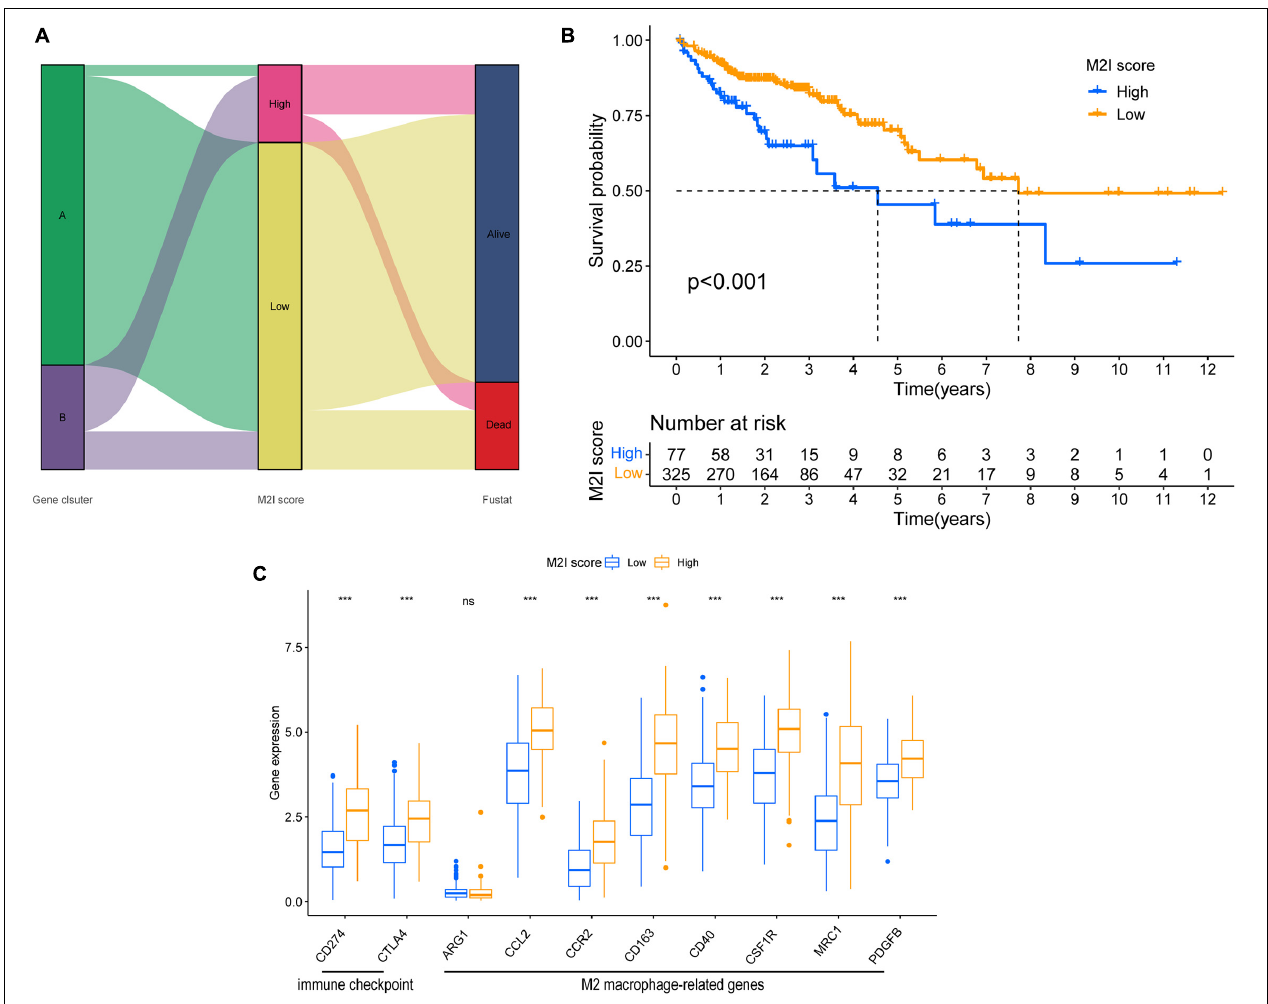
FIGURE 4 | Construction of the M2I score. (A) Sankey plot of survival outcomes in the distribution set of M2I scores in different subgroups. (B) Survival difference between groups with high and low M2I rating. (C) Immune checkpoint related genes and M2 macrophage related genes were expressed in the subgroups with high and low M2I